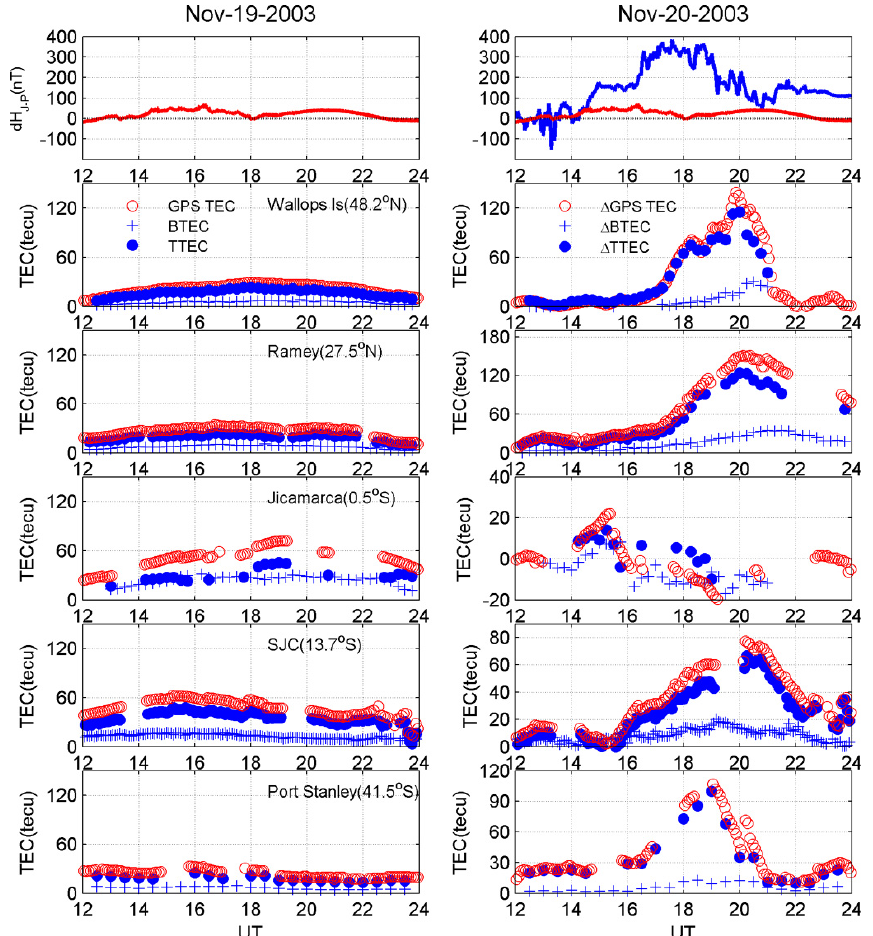
Fig. 3. Ionosonde bottomside TEC (BTEC), topside ionospheric TEC (TTEC) and GPS TEC variations as a function of time for the Latin America sector: (left) quiet day 19 November and (right) difference value of each parameter after subtracting the quiet day value on the storm day 20 November 2003. The station name and geomagnetic latitude are labeled on top of each quiet-day panel. The top two panels show dH J-P for the quiet day (red) and the storm day